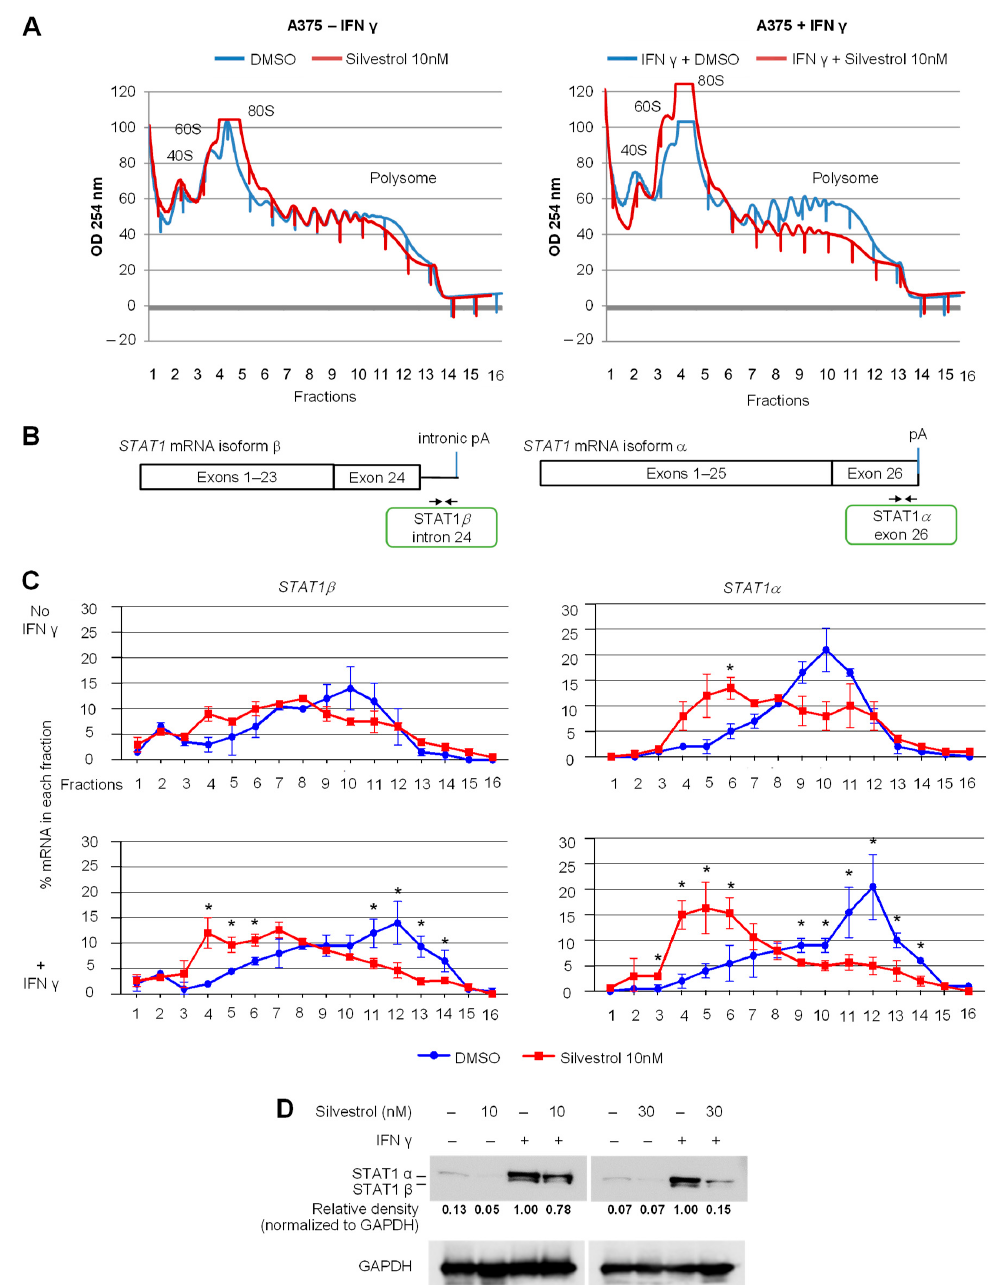
Figure 2 Figure 2. Both STAT1 mRNA isoforms are regulated at the translational level by eIF4A inhibition. ( A ) Polysome profiles of A375 cells treated with IFN- γ for 24 h and silvestrol (10 nM) for 2 h. One representative profile from three independent experiments is shown; ( B ) primer design for RT-qPCR detection of STAT1 mRNA isoforms; ( C ) percentage of transcripts for each STAT1 APA isoform in each polysomal fraction obtained by sucrose-gradient ultracentrifugation was quantified by RT-qPCR ( n = 3). p -values were calculated using two-tailed unpaired t -test (* p ≤ 0.05); ( D ) Western blot analysis to look into the expression of STAT1 APA isoforms in A375 cells treated with IFN- γ for 24 h and silvestrol (10 nM or 30 nM) for 24 h. Quantification of STAT1 expression was performed by calculating the relative densities normalized to GAPDH levels. One representative blot from three independent experiments is shown (uncropped western blot original images see Figure